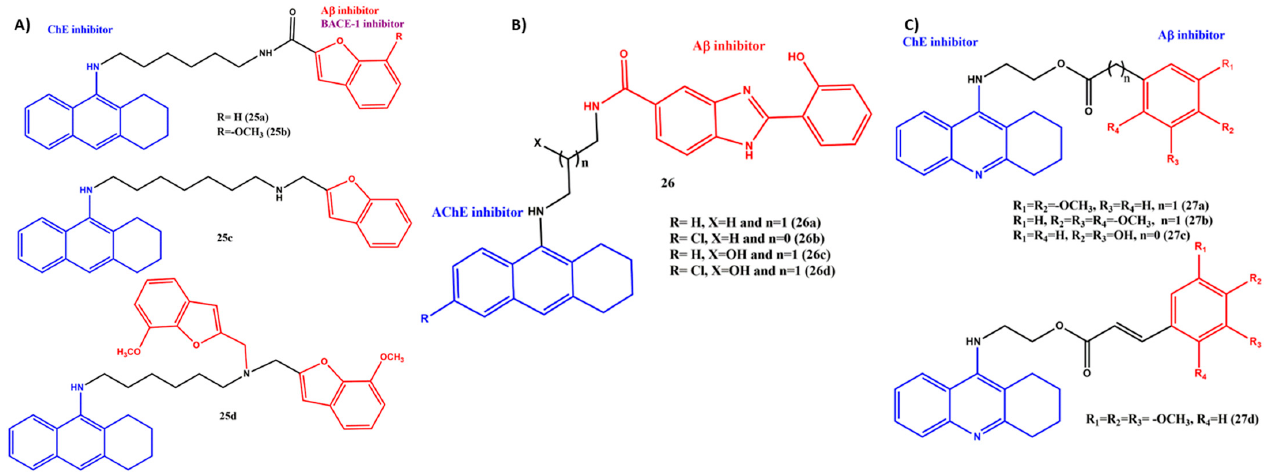
Figure 10. ( A − C ) Chemical structures of tacrine-derived MTDLs for AD. Figure 10. ( A – C ) Chemical structures of tacrine-derived MTDLs for